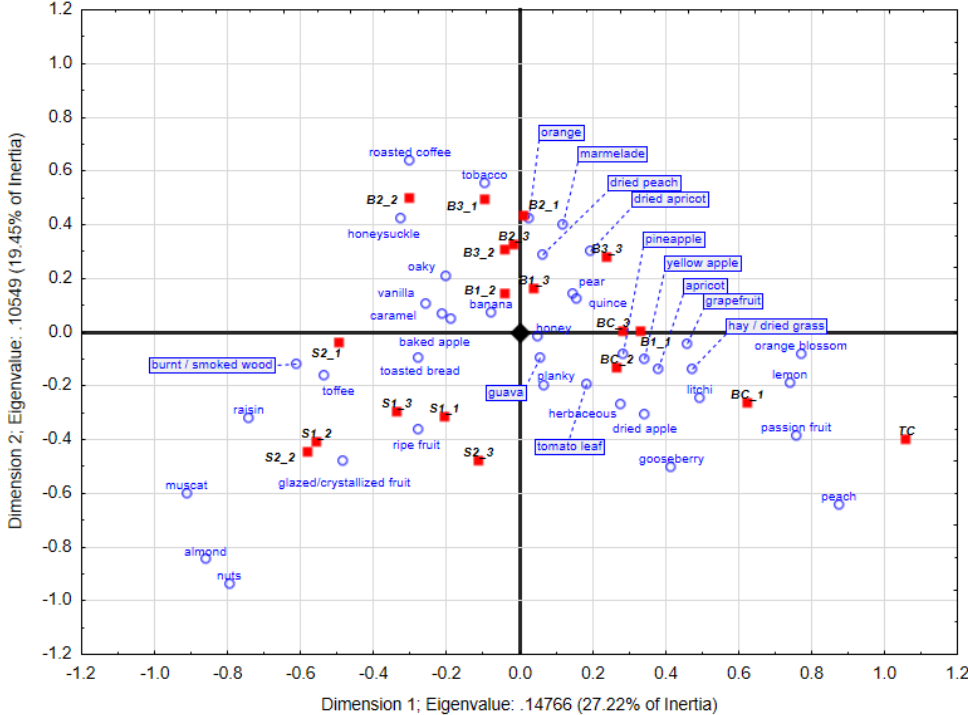
Figure 2. Correspondence analysis obtained with the trained panel ( n = 20) after 9 months of oak maturation from Pick K data. Certain descriptors (boxed) have been moved to improve the readability of the plot. TC: tank control, BC: barrel control, B: new barrel treatments, S: stave treatments.